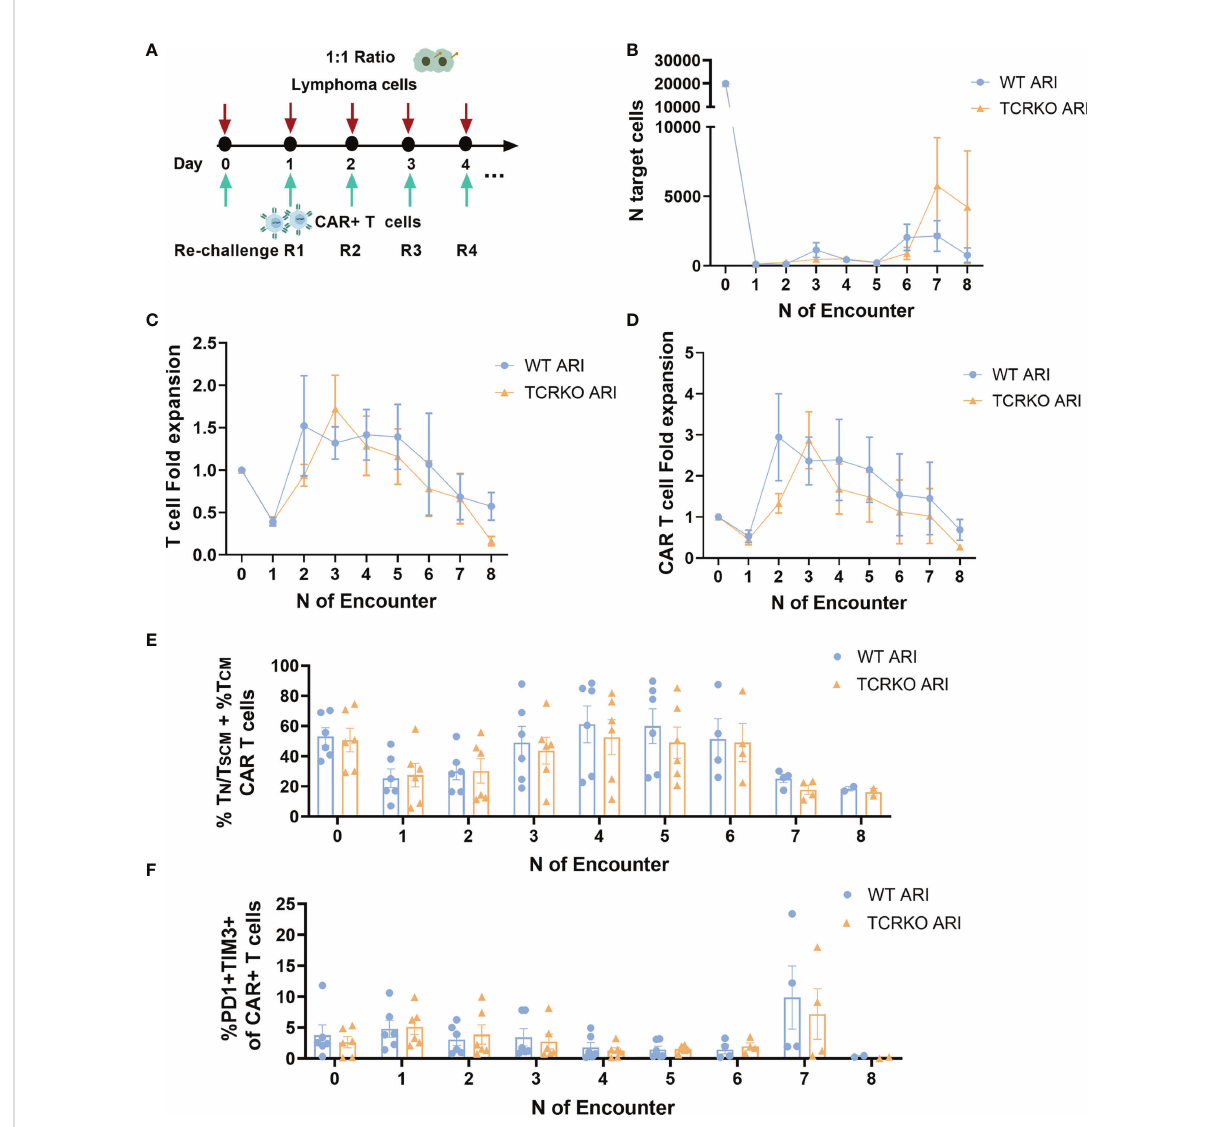
FIGURE 5 TCRKO CAR T cells maintain effector potency after highly repetitive tumor re-challenge. (A) Schema of second tumor re-challenge assay. CAR- T cells were co-cultured with Namalwa cells (E:T = 1:1) and rechallenged every day. (B) Graph showing number of remaining tumor cells quanti fi ed by fl ow cytometry every 24h. (C, D) Graph showing T cell (C) or CAR-T cells (D) fold expansion after every encounter relativized to the initial numbers of seeded cells. (E) Percentage of T N /T SCM +T CM of WT ARI-0001 and TCRKO ARI-0001 after the different re-challenges with Namalwa cells. (F) Graph showing the percentage of PD1+TIM3+ cells in WT ARI-0001 and TCRKO ARI-0001 after the different re-challenges with Namalwa cells. Graphs show mean ± SEM of n=6 independent